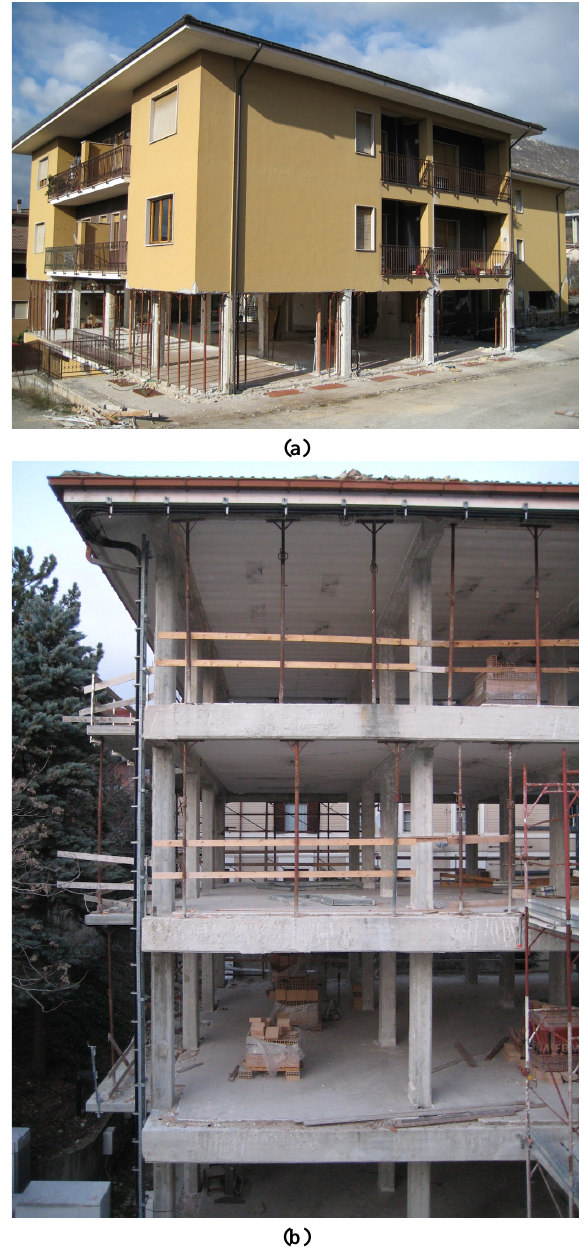
Fig. 4. Example of special case 1, top panel, (a) , and special case 2, bottom panel, (b)